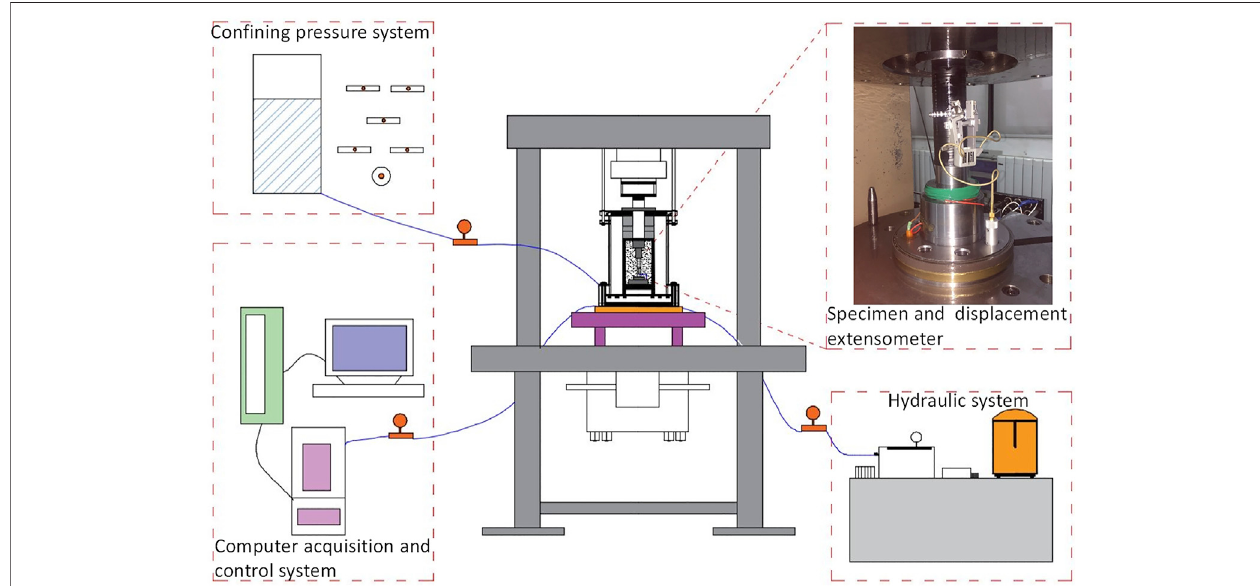
FIGURE 3 | MTS815 electro-hydraulic servo rock test system.